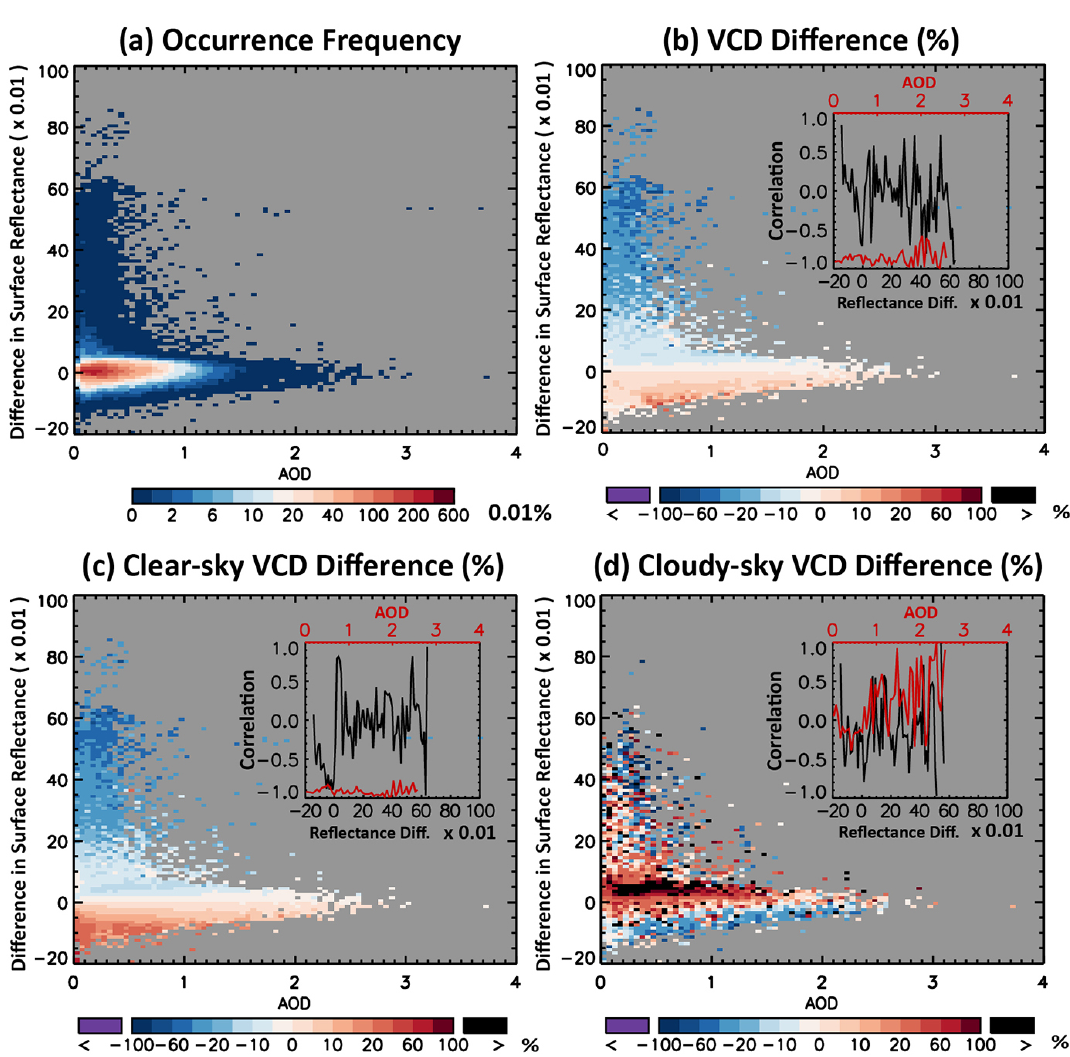
Figure 8. (a) Frequency of occurrence from all months and grid cells for each bin of AOD ( x axis, bin size 0.05) and surface reflectance difference (OMI albedo in case SRF minus MODIS BRF in case REF, y axis, bin size 0.01). Data are sampled from valid pixels of case REF. (b) Percentage changes in NO 2 VCDs from case REF to SRF averaged over all data in each bin of AOD and surface reflectance difference; also embedded are the correlations between percentage VCD changes and AOD values as a function of surface reflectance differences (black line) and between VCD changes and surface reflectance differences as a function of AOD values (red line). Similar panels are drawn for (c) clear-sky VCDs and (d) cloudy-sky